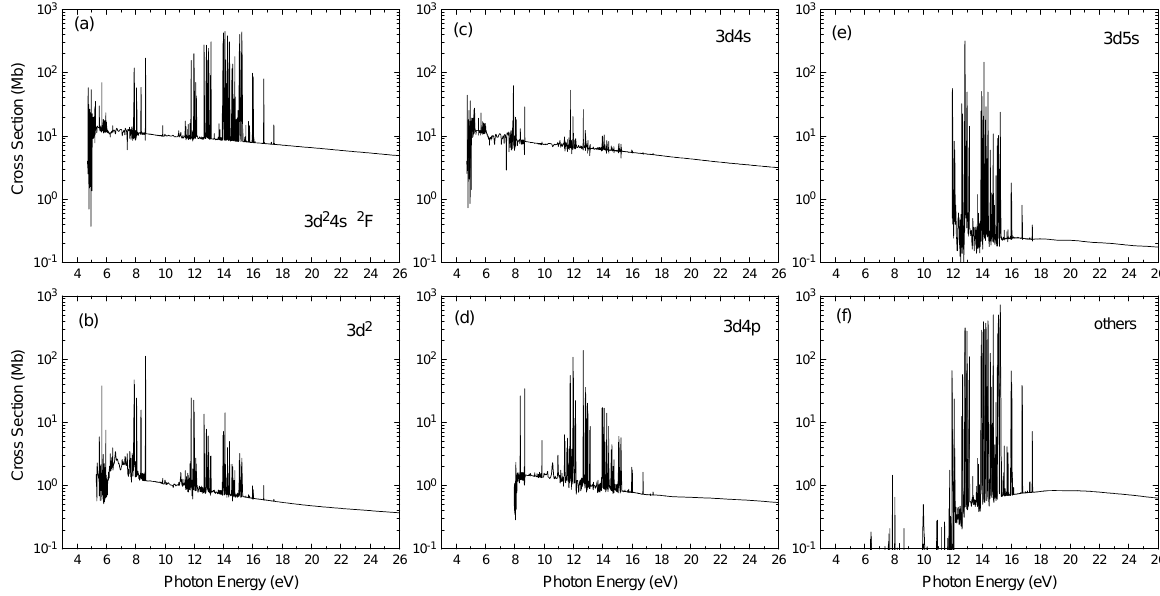
Figure 2. Cross sections for photoionization from the excited 3 d 2 4 s 2 F state of Sc. ( a ) total cross-sections from the present BSR-81 model and ( b – f ) show summed partial cross-sections for leaving the residual Sc + ion in the final states of the 3 d 2 , 3 d 4 s , 3 d 4 p , and 3 d 5 s configurations, respectively, along with contributions of all other